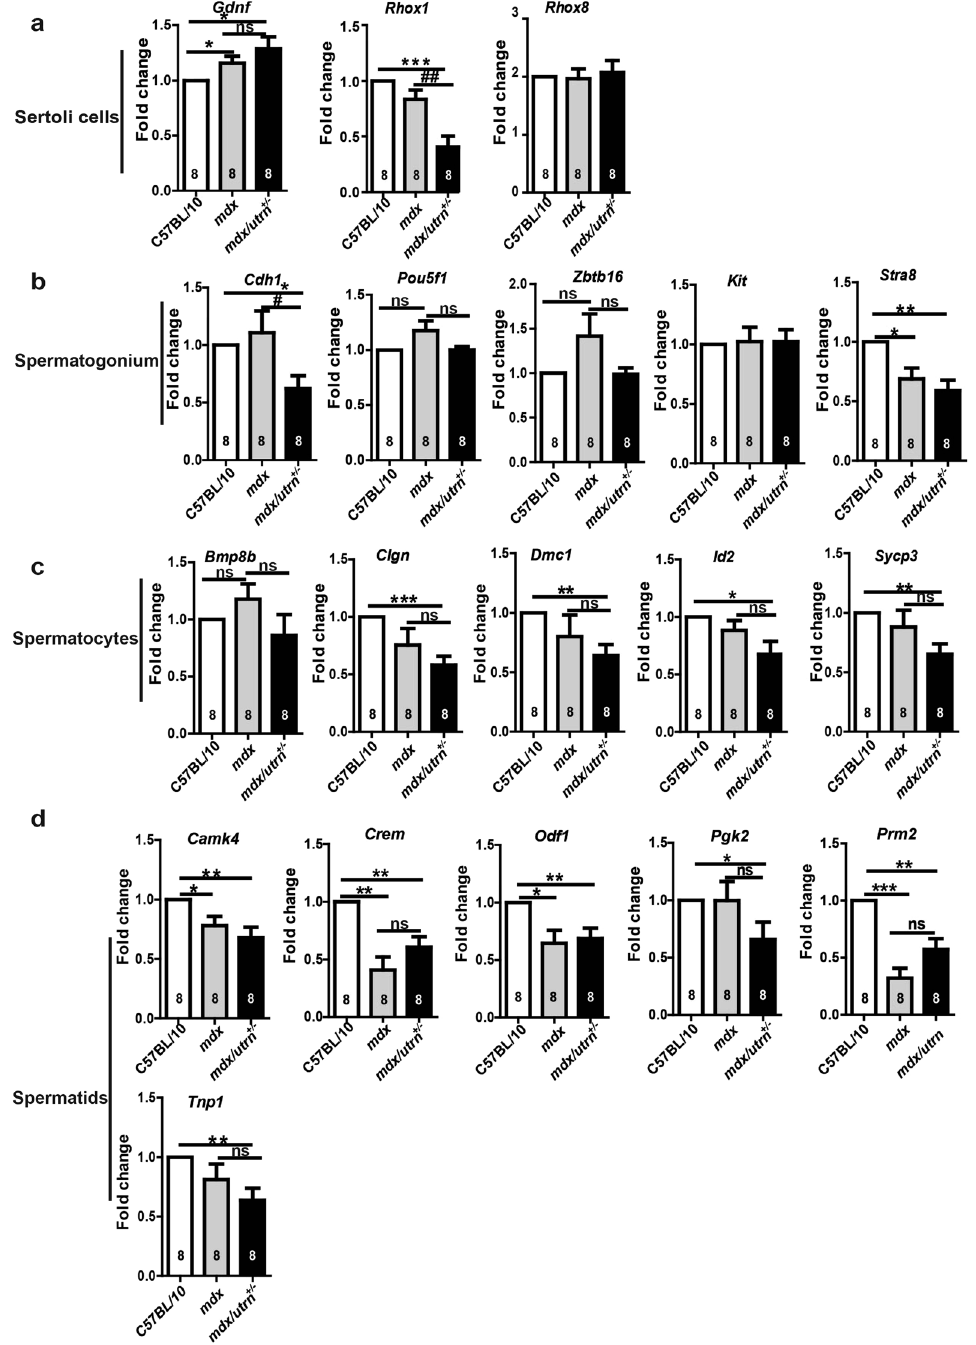
Figure 5. Deficiency of dystrophin/utrophin perturbs gene expression for spermatogenesis. The testes of the ten-week-old mice were homogenized for mRNA isolation. The expression of genes specific for germ cells of each stage was examined using quantitative PCR. ( a ) Sertoli cell-specific genes Gdnf , Rhox1 and Rhox8 in C57BL/10, mdx and mdx/utrn + / − testes. ( b ) The expression of genes specific for spermatogonia in C57BL/10, mdx and mdx/utrn + / − testes: Cdh1 , Kit , Pou5f1 , Zbtb16 and Stra8 . ( c ) Genes specific for spermatocytes in C57BL/10, mdx and mdx/utrn + / − testes: Bmp8b , Clgn , Dmc1 , Id2 and Sycp3 . ( d ) Expression of the spermatid- specific genes in C57BL/10, mdx and mdx/utrn + / − testes: CamK4 , Crem , Odf1 , Pgk2 , Prm2 and Tnp1 . Data were analyzed with one-way ANOVA; n = 6. All values are represented as mean ± SEM. ns: not significant. * compared with the C57BL/10; # compared with the mdx . # P < 0.05; ## P < 0.01; * P < 0.05; ** P < 0.01; *** P <